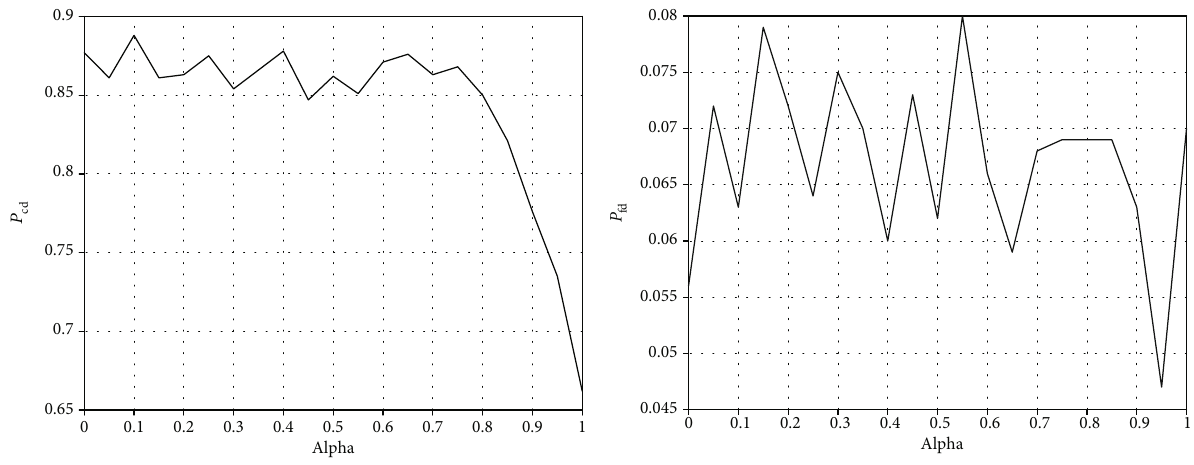
Figure 18: The relationship curves between P